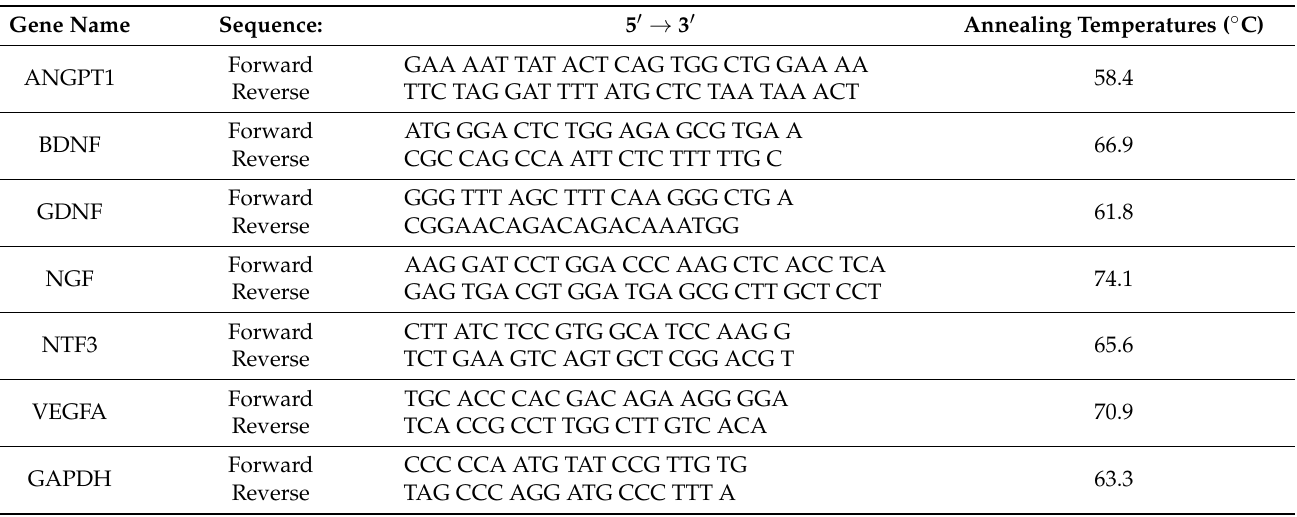
Table 1. PCR primers used to quantify mRNA